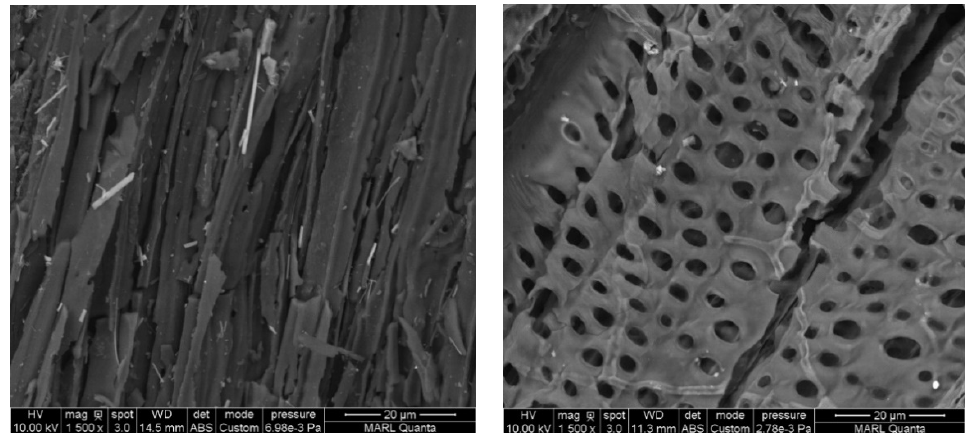
Figure 4. Comparison of the SEM images of biochar pellets ( left ) and biochar powder ( right ) shows morphological changes during pelletization.